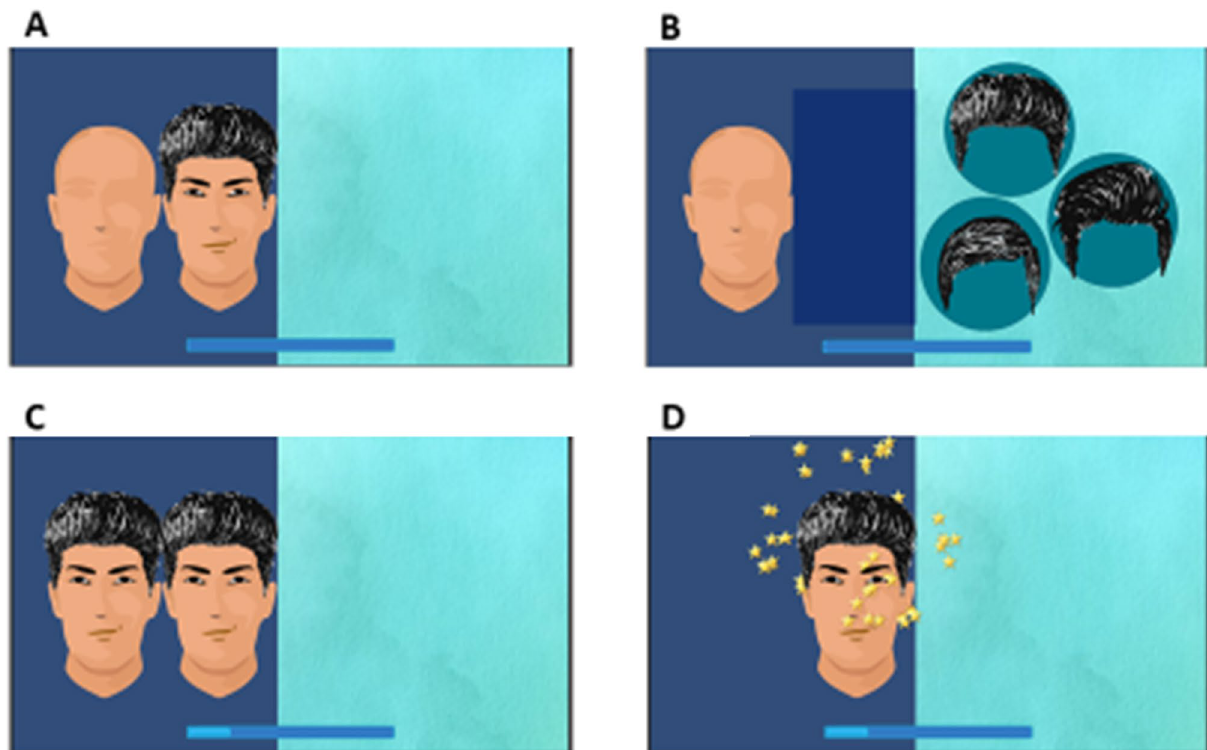
Figure 4. Face game gameplay. ( a ) At the start of a level, a model face and an empty face lacking facial features are shown. ( b ) After a delay the model face is covered and for each facial feature the player is shown three options, from which the player selects one to add to the empty face, in attempt to make it the same as the model face. ( c ) Once all the components are added to the empty face, the model face is revealed and the similarity between the two is assessed. ( D ) A pleasant audio-visual feedback is given if the two faces match